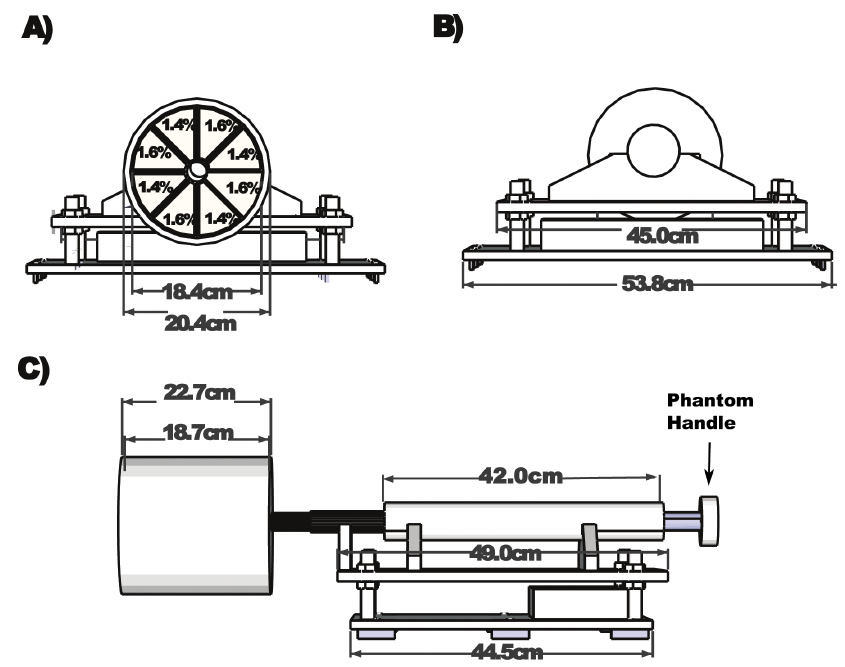
Fig 1. Front and Side view of the cylindrical phantom. Top left: Front view of phantom/ Alternating Agar concentrations are labeled for the wedge compartments. Diameter dimensions of head phantom, which is inserted into a head coil are shown. Top right: Back view of phantom with handle. Handle turns 45 degrees clockwise and counter clockwise creating two “ states ” during fMRI experiments. Bottom: Side view of phantom. The lower base inserts and thus locks into patient